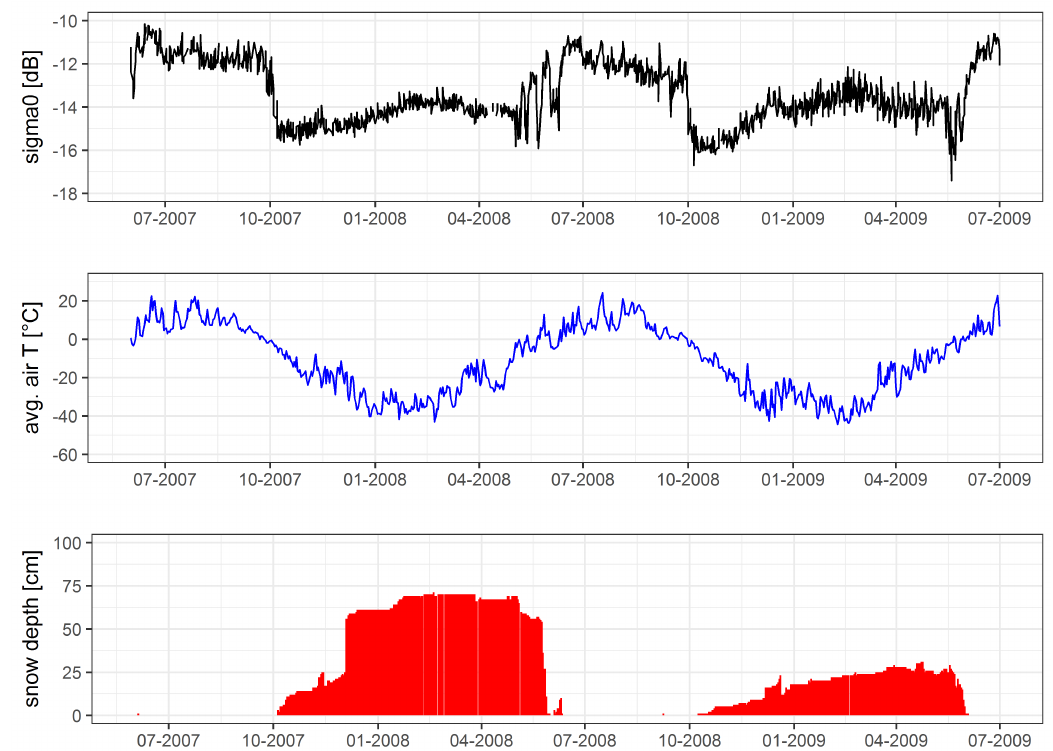
Figure 1. Advanced Scatterometer (ASCAT) backscatter (dB), air temperature (°C) and snow depth (cm) for the World Meteorological Organization (WMO) station Chokurdah Nr. 21946 (70.617,